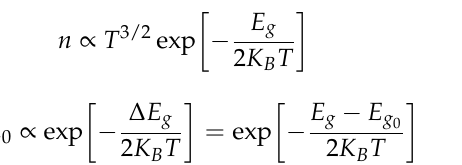
Figure 9. The orientation distribution curves of intrinsic charge carrier concentration ratio ( a ) PbPdO 2 , and ( b ) PbPd 0.75 Co 0.25 O 2 with ε = − 0.02 and